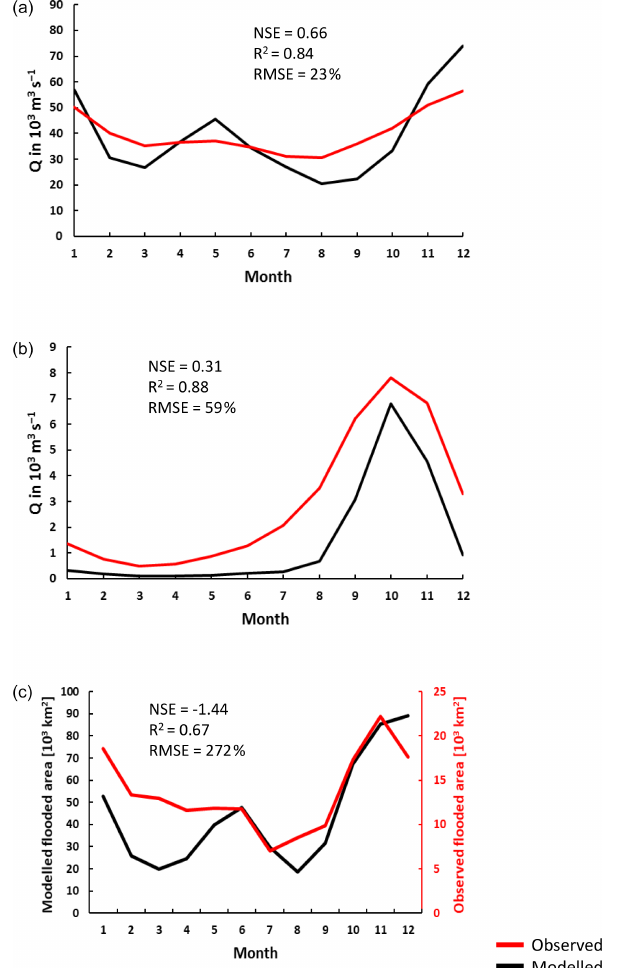
Figure 4. Seasonality of simulated versus observed discharge at (a) Brazzaville on the Congo (for the 1990–2005 monthly mean; Cochonneau et al., 2006), (b) Bangui on the Oubangui (2010– 2012; Bouillon et al., 2014), and (c) flooded area in the central (approx. 200000km 2 ) part of the Cuvette Centrale wetlands ver- sus GIEMS (1993–2007; Becker et al., 2018). The observed flooded area data represent the maximum minus minimum (permanent wa- ter bodies such as rivers) GIEMS inundation. See Fig. 1 for loca-